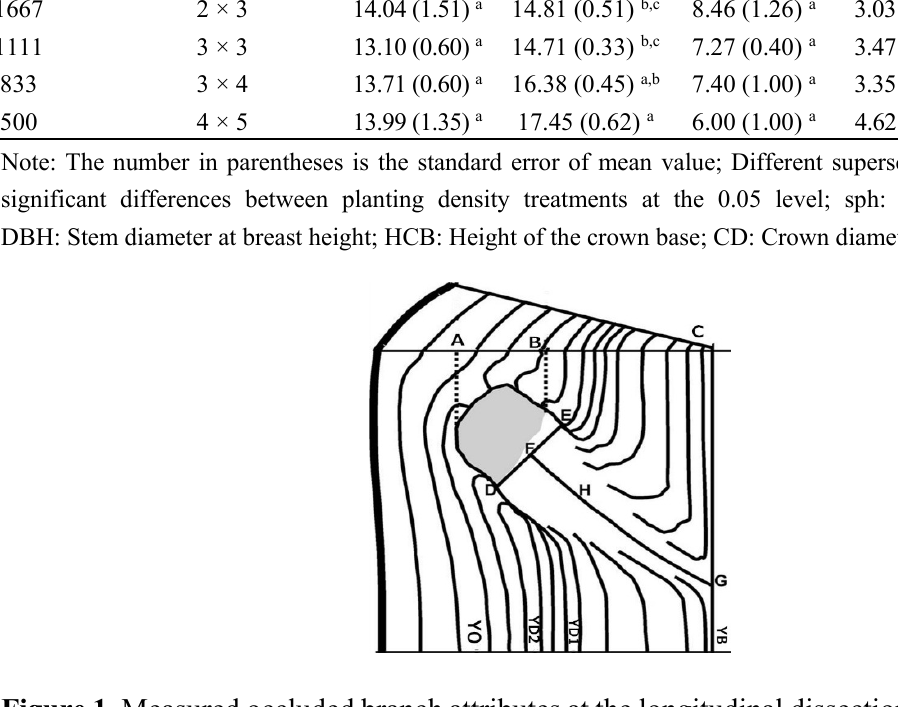
Figure 1. Measured occluded branch attributes at the longitudinal dissection (modified from Hein [19]). The shaded portion of occluded branch is the dead knot; the remaining portion of occluded branch is the live